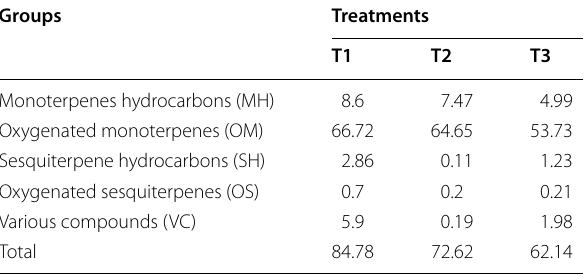
Table 3 Percentage of different chemical